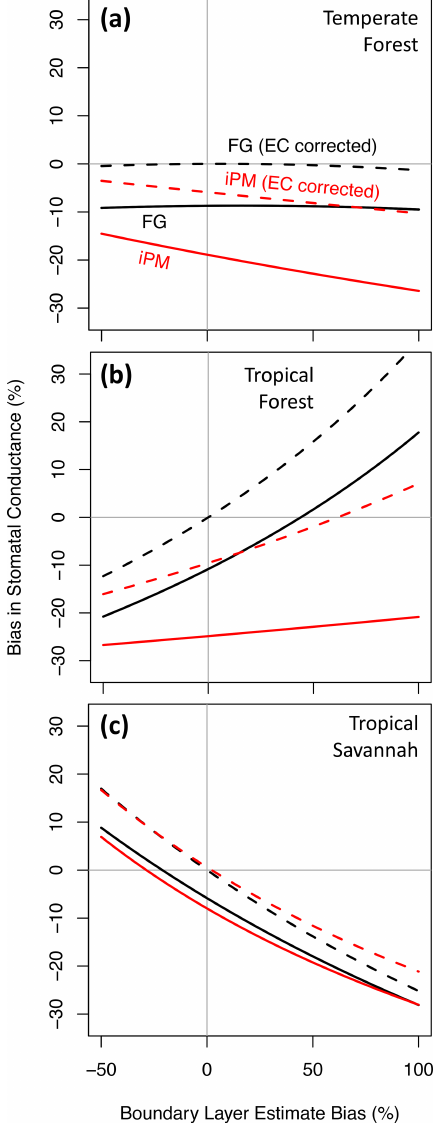
Figure 3. Proportional bias in canopy stomatal conductance ob- tained from the flux–gradient (FG, black) and inverted Penman– Monteith (iPM, red) formulations versus proportional bias in the measured Bowen ratio. Solid lines show results without eddy flux correction, and dotted lines show results with the eddy fluxes ad- justed to close the long-term energy budget while preserving the (erroneously measured) Bowen ratio. The unshaded region denotes the plausible range of pervasive bias, which is bounded by the buoyancy-flux-based and Bowen-ratio-preserving limits (see text).